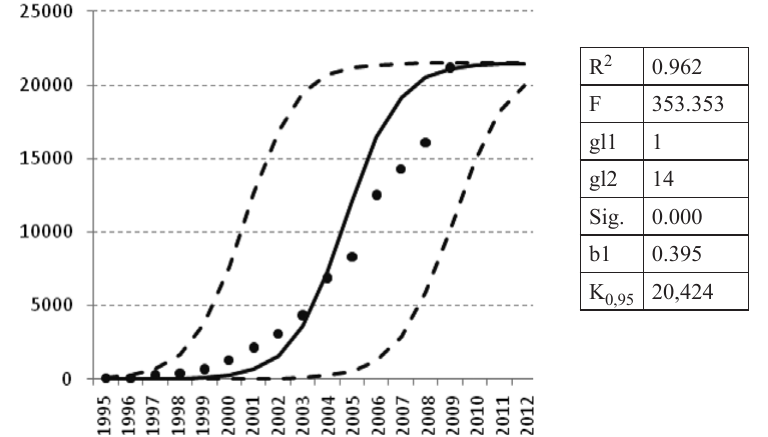
Fig. 11. Forecast of the ISO 9000 certificates in the countries joined in 2007 Source: Own preparation on the basis of ISO full reports of global statistics for ISO 9000 (ISO